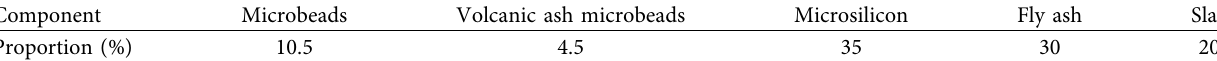
Table 3: Components of the low-density mixture and their proportions.